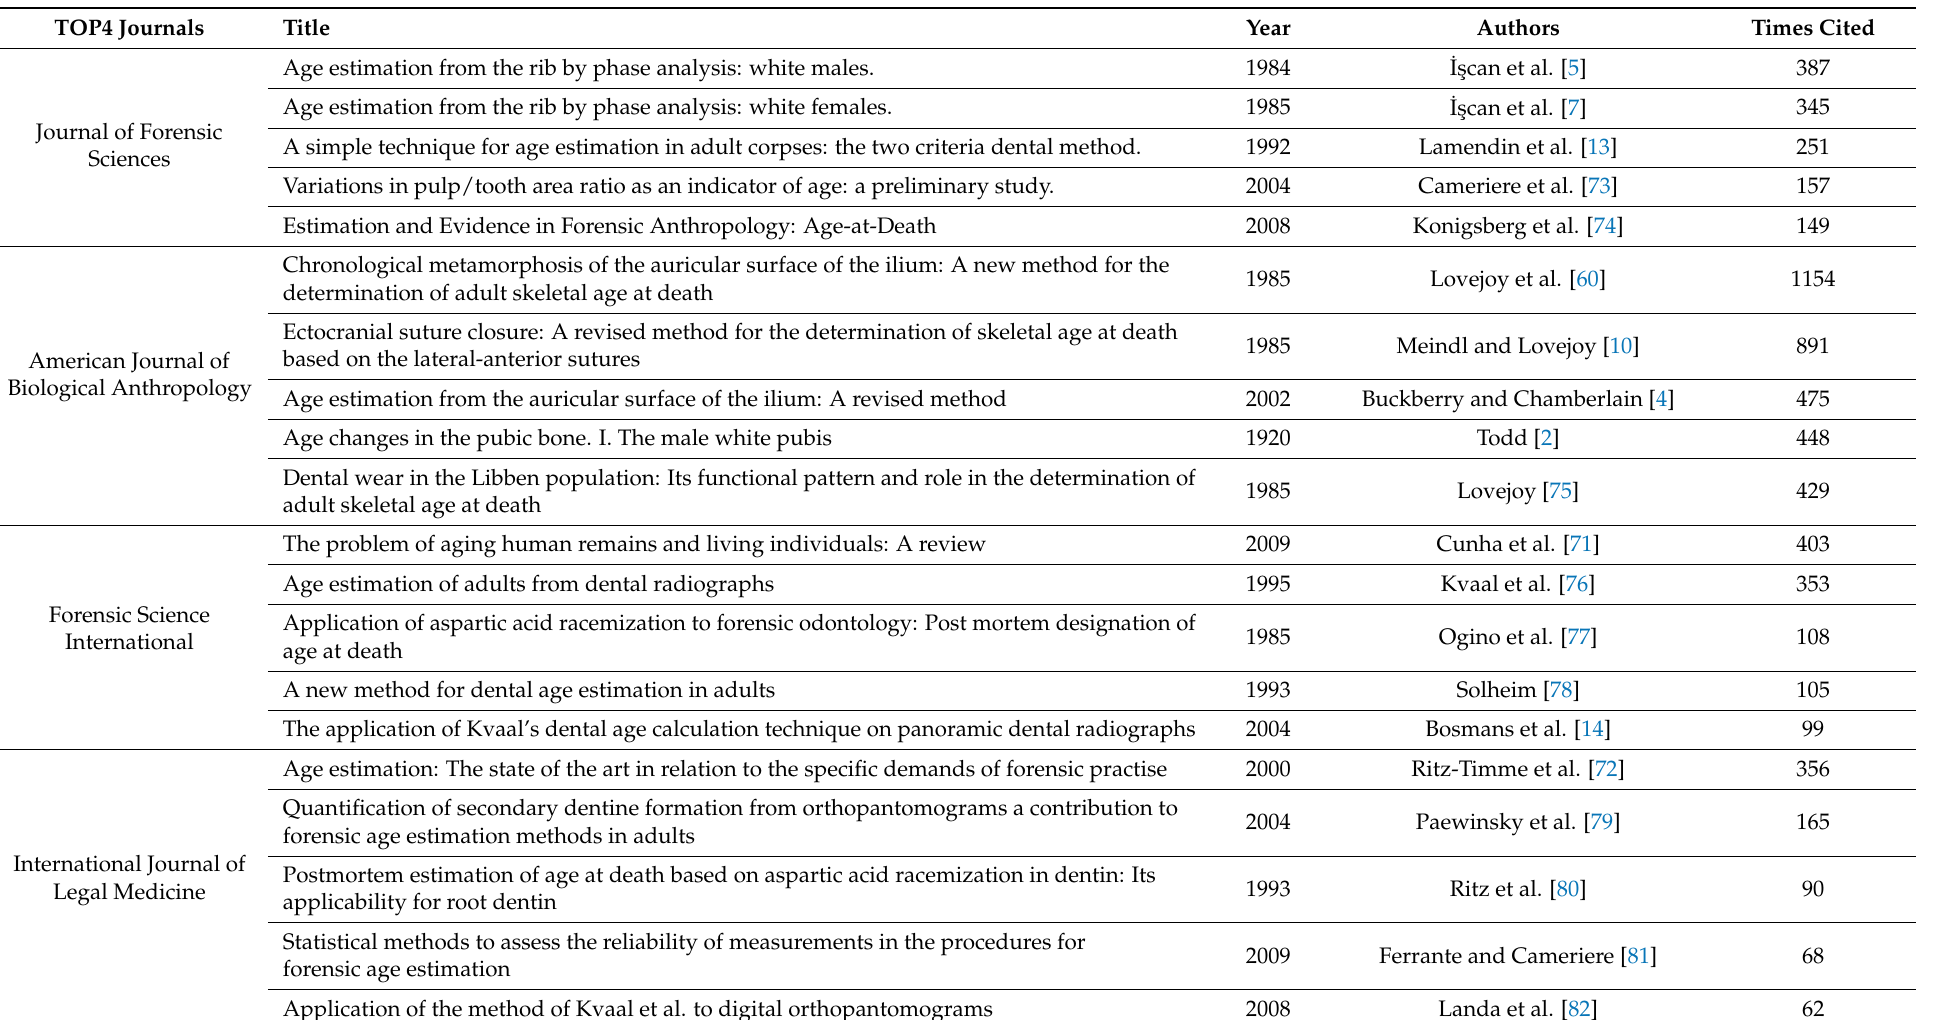
Table 3. TOP5 titles most cited for the TOP4